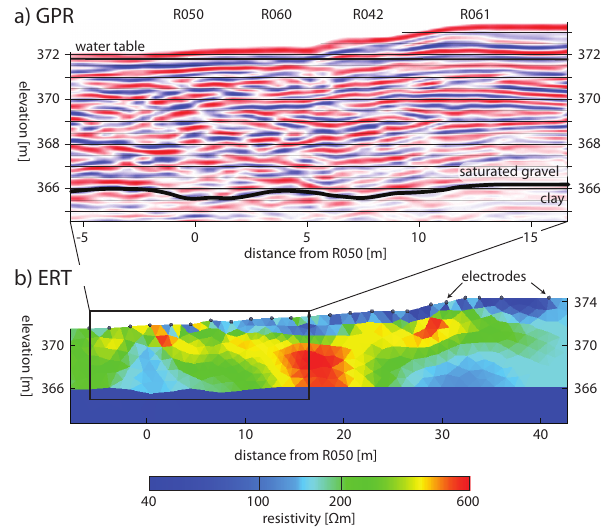
Fig. 5. (a) GPR reflection profile and (b) ERT model obtained in the beginning of the forest transect (transect B in Fig. 2). GPR reflec- tions provide high-resolution information about lithological varia- tions, whereas ERT provides information about average porosities and clay content at a lower resolution.